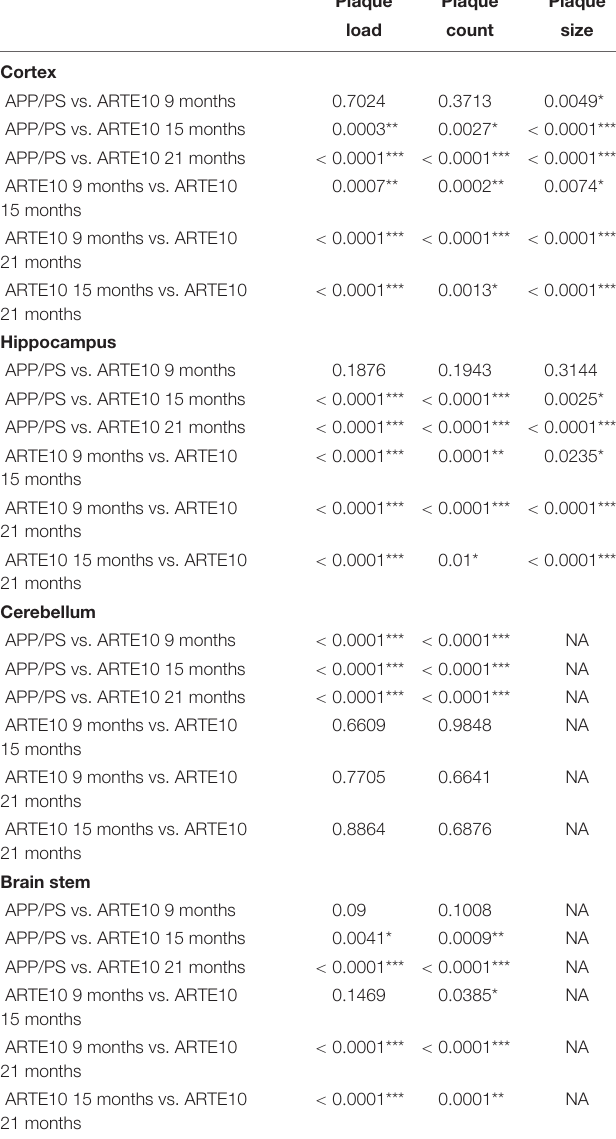
TABLE 2 | Statistical analyses of plaque quantification on Congo red–stained brain slices from APPswe/PS1 (cid:49) E9 (APP/PS, 24 months) and ARTE10 mice of different ages (9–21